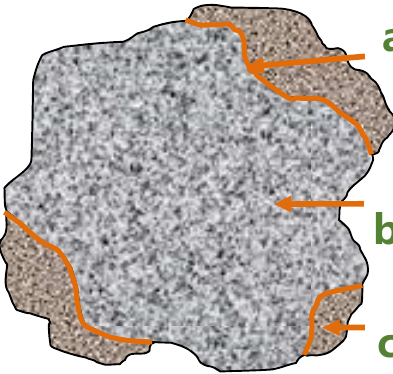
Figure 3. Appearance of the recycled coarse aggregate and attached mortar.